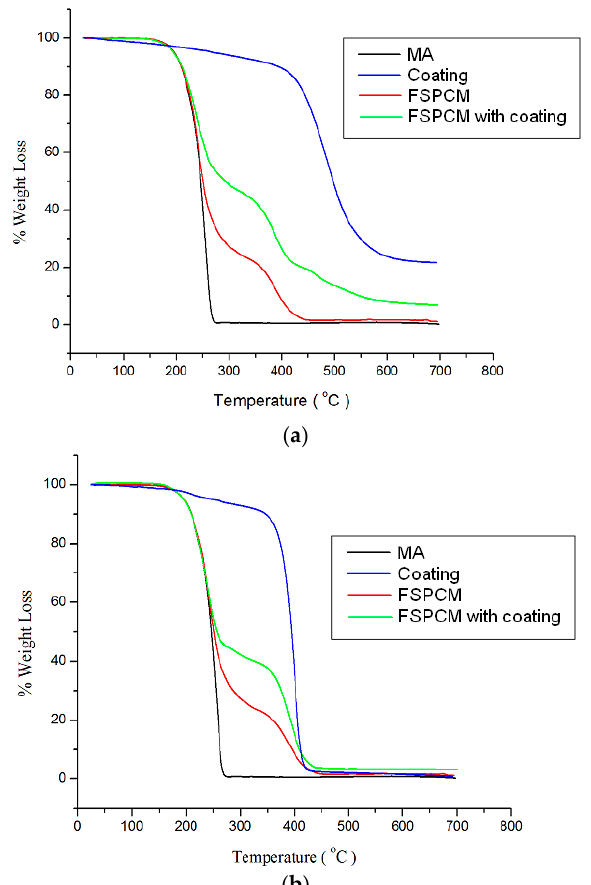
Figure 6. Thermogravimetric analyzer (TGA) curves for ( a ) conformal coating and ( b ) polyacrylic coating.